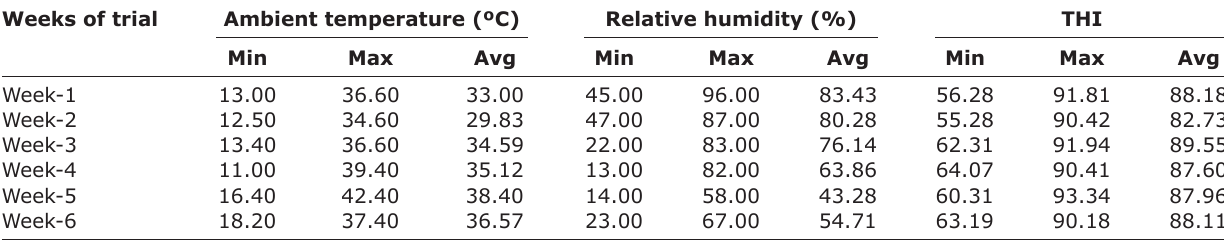
Table-3: Ambient temperature, relative humidity and THI observed during different weeks of experimental trial. Weeks of